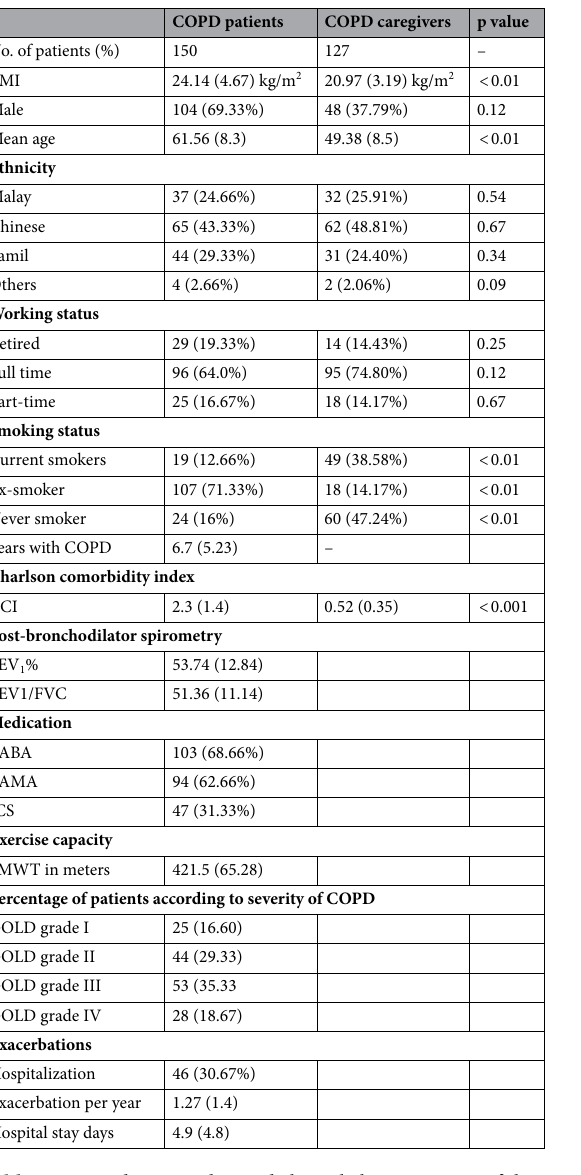
Table 1. Sociodemographic and clinical characteristics of the COPD patients and their caregivers. Results were displayed as mean (standard deviation) and number (percentage) unless otherwise stated. BMI, Body mass index in kg/m 2 ; COPD, Chronic obstructive pulmonary disease; CCI, Charlson comorbidity index; FEV 1 , forced expiratory volume in one second; FVC, forced vital capacity; FEV1%, % predicted FEV 1 ; GOLD 1,